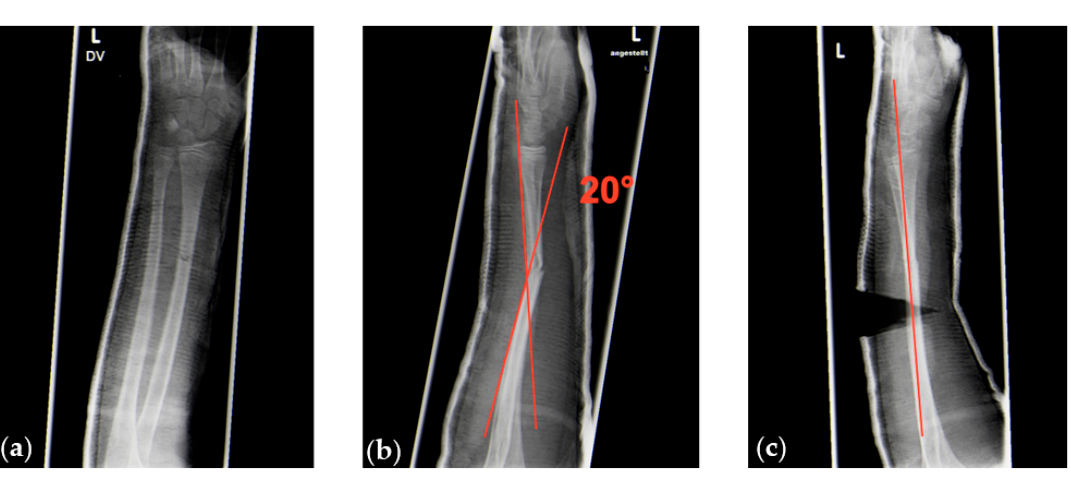
Figure 5. ( a , b ) Radiologic images of a sagittal 20° angular deformity of a greenstick fracture between midshaft and distal forearm shaft region without deformity in the coronal plane ( a ). ( c ) Complete correction of the deformity after cast wedging.